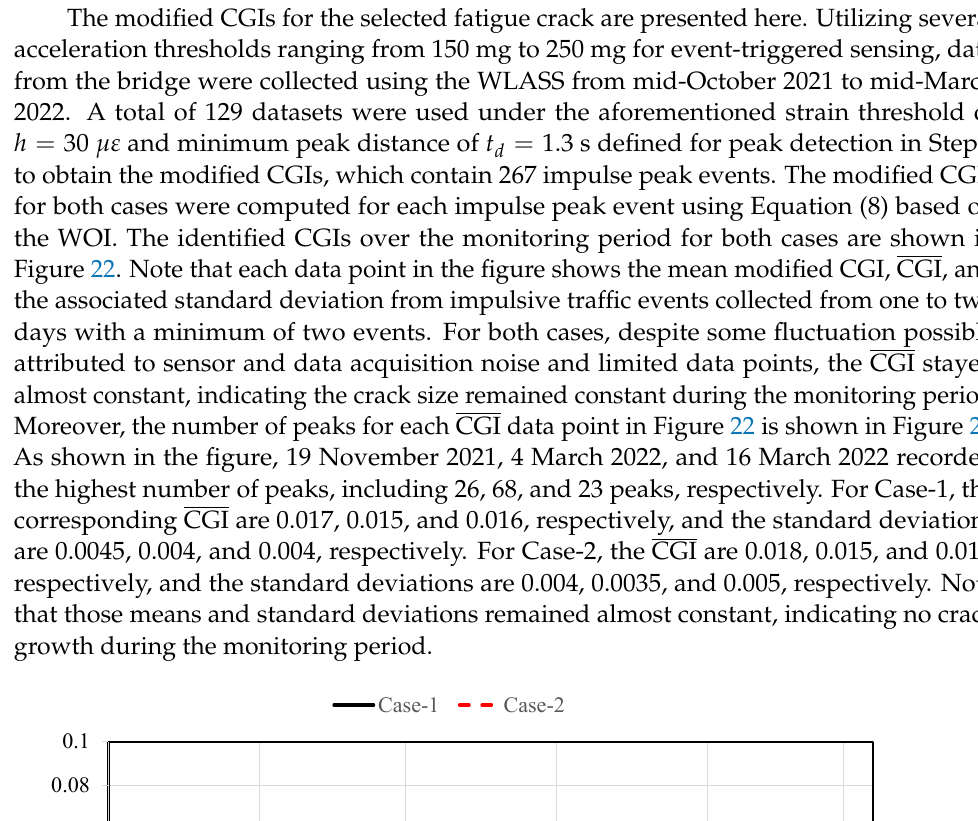
Figure 21. Peak identification within the identified WOIs under the multiple traffic events for ( a ) strain, F ( t ) , measurement, and ( b ) ∆ C ( t ) from SEC.